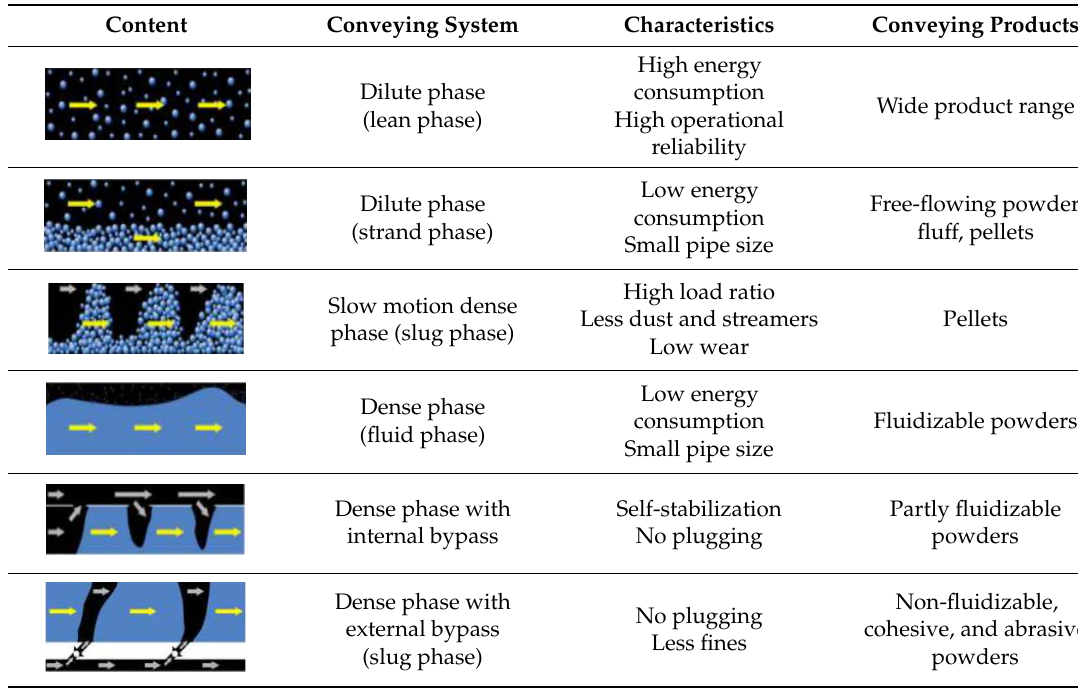
Table 1. Type and characteristics of BTS [25].